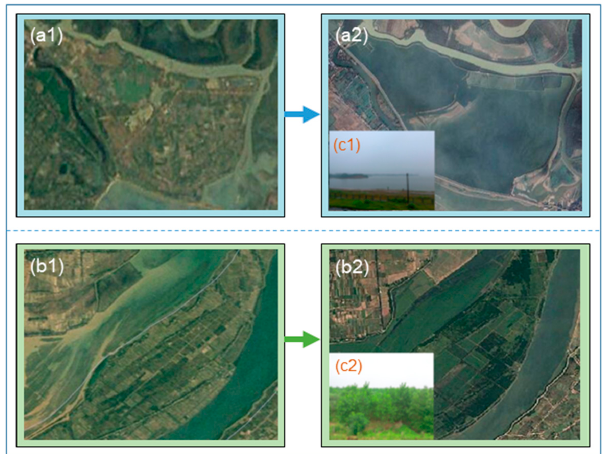
Figure 2. Two examples areas of each cropland change pattern. Corresponding photos a1 and a2, b1 and b2 before and after CFTL are from google earth to demonstrate the process of conversion to lake, poplar cultivation respectively. Figures a1 and b1 represent the years 1997 and figures a2 and b2 the years 2018. Field photographs c1 and c2 were collected in 2018.